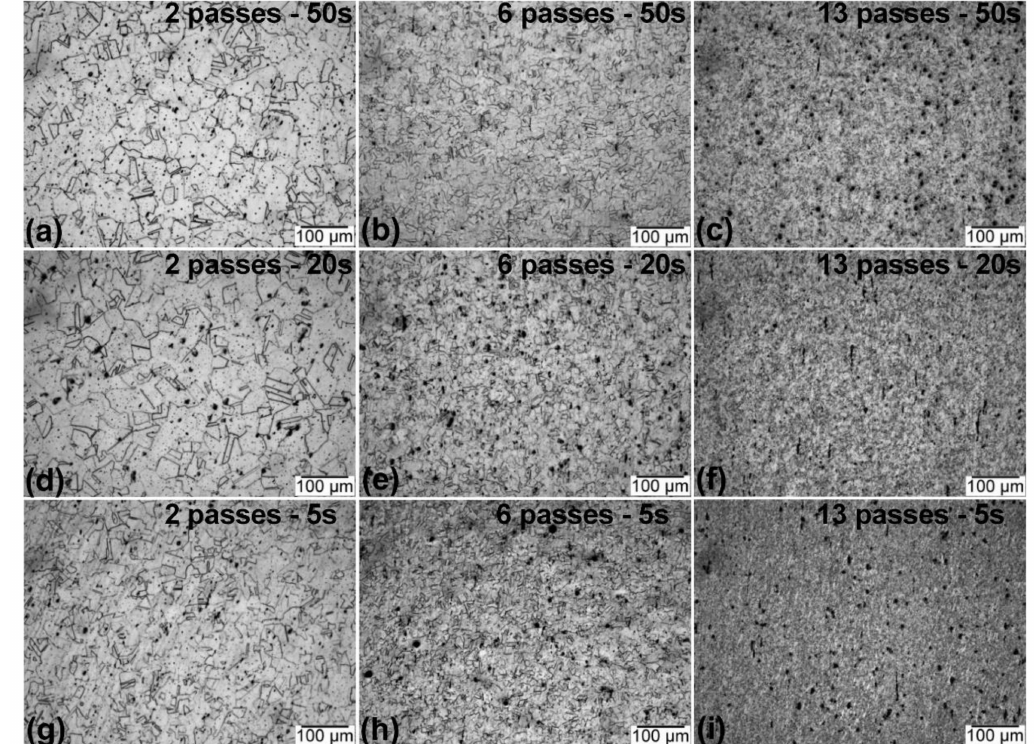
Figure 5. ( a ) 2 passes—50 s, ( b ) 6 passes—50 s, ( c ) 13 passes—50 s, ( d ) 2 passes—20 s, ( e ) 6 passes—20 s, ( f ) 13 passes—20 s, ( g ) 2 passes—5 s, ( h ) 6 passes—5 s, ( i ) 13 passes—5 s. Optical micrographs